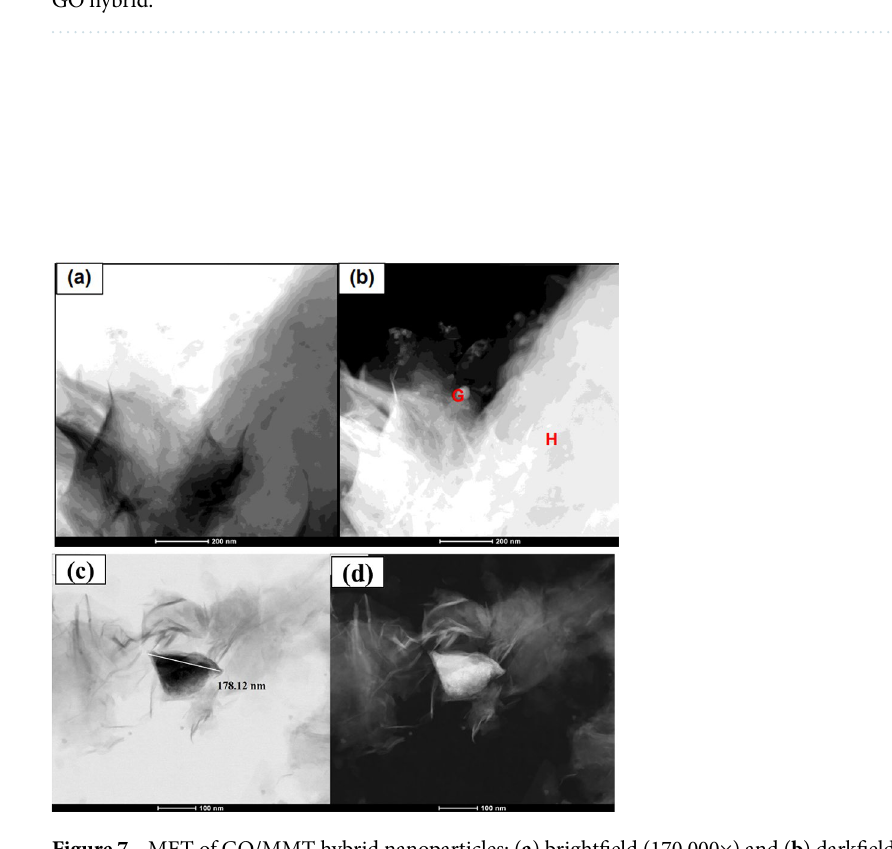
Figure 7. MET of GO/MMT hybrid nanoparticles: ( a ) brightfield (170,000×) and ( b ) darkfield